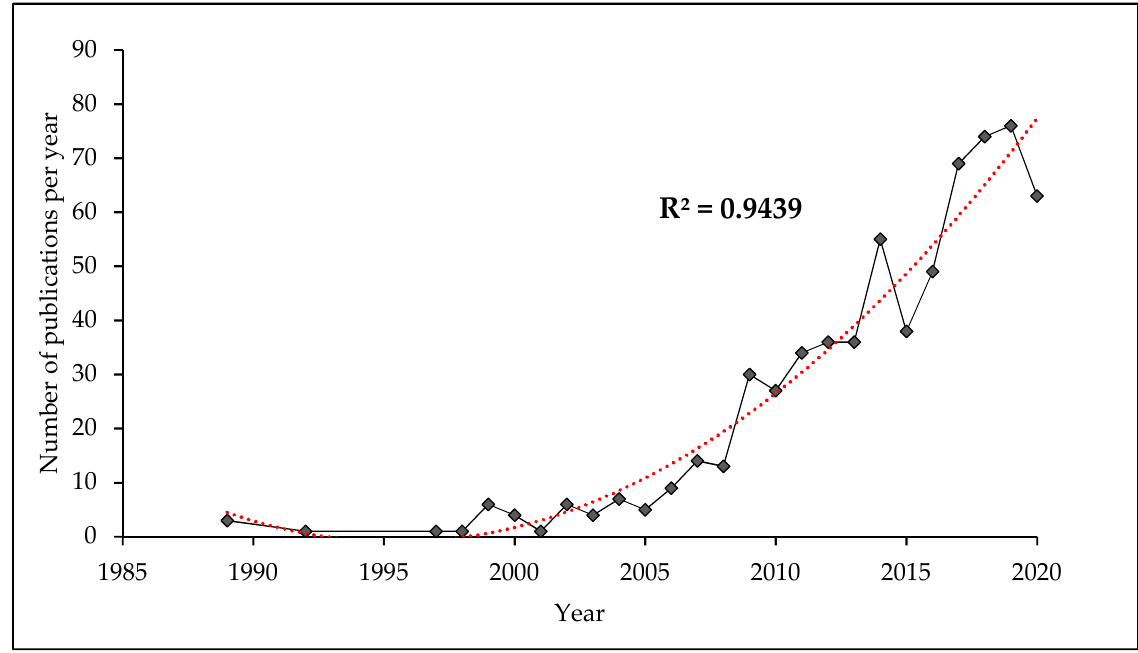
Figure 1. Trend in the number of published studies in which the Dickson Quality Index has been used as an indicator of plant quality.